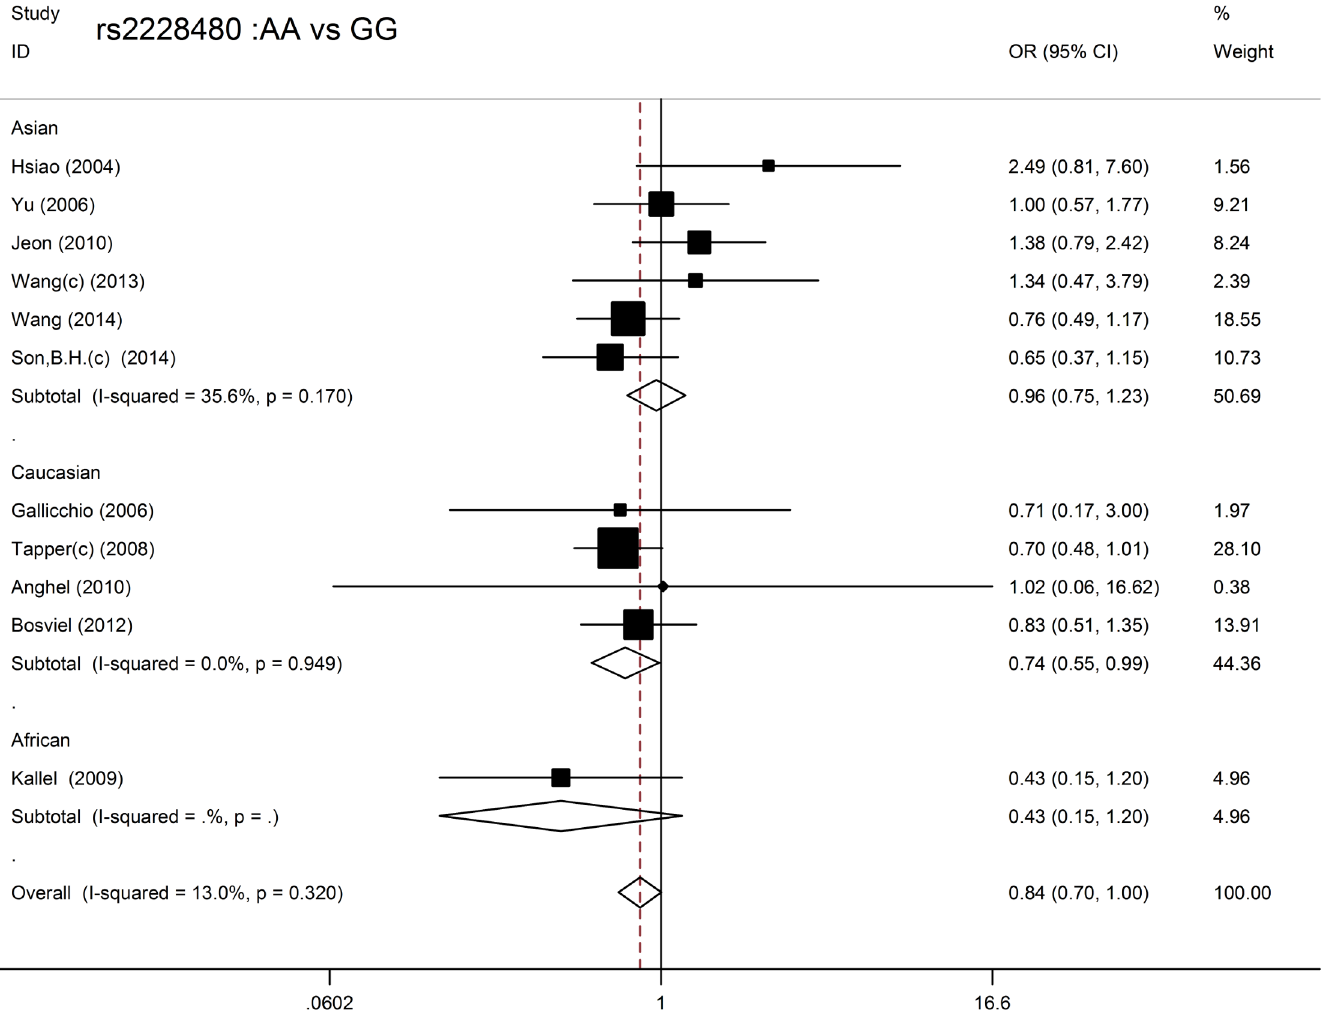
Fig 2. Forest plot of the association between rs2228480 and breast cancer risk in different ethnicities in the variant homozygote versus wild-type homozygote